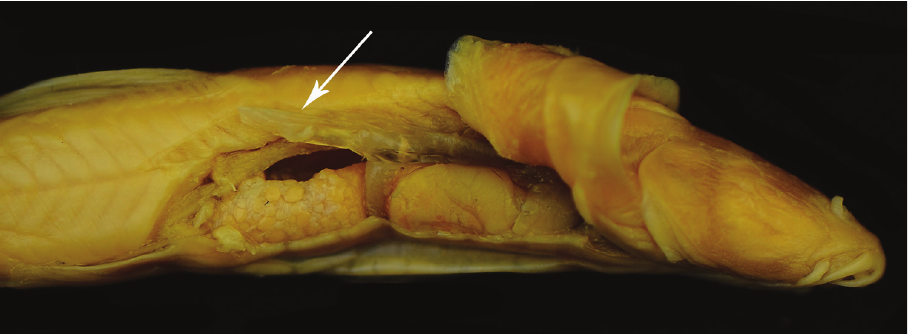
Figure 3. Posterior chamber of air bladder of Triplophysa anshuiensis sp.